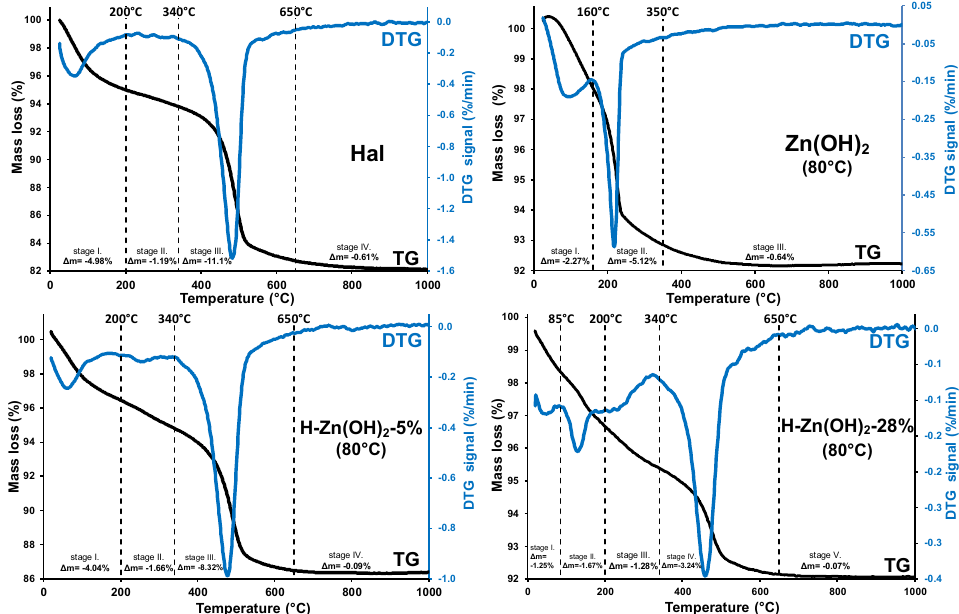
Figure 3. Typical thermoanalytical curves (TG/DTG) of the investigated samples.